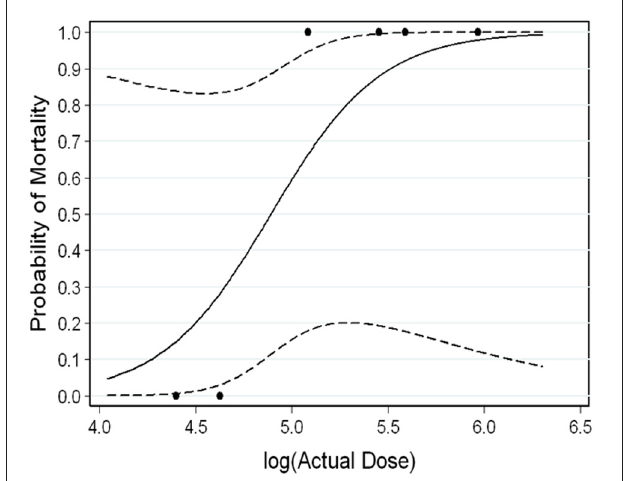
FIGURE 2 | Survival Data Logistic Regression Curve showing the survival data as well as the logistic regression curve fit to the data. Dashed lines represent the 95% confidence